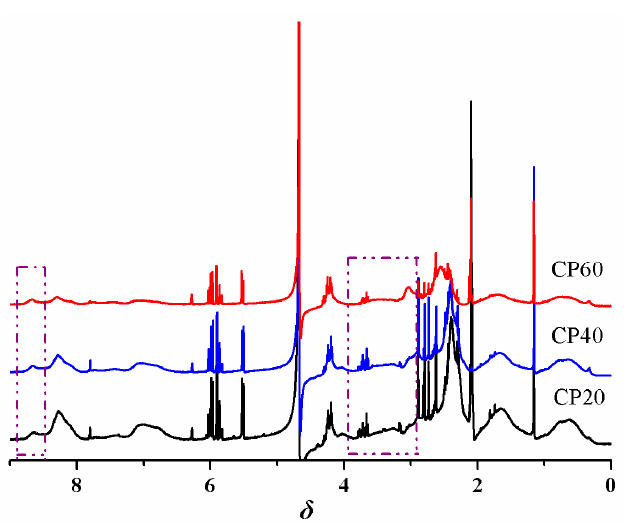
Figure 2. 1H NMR spectrum of CP20, CP40, and CP60 in D 2 O.